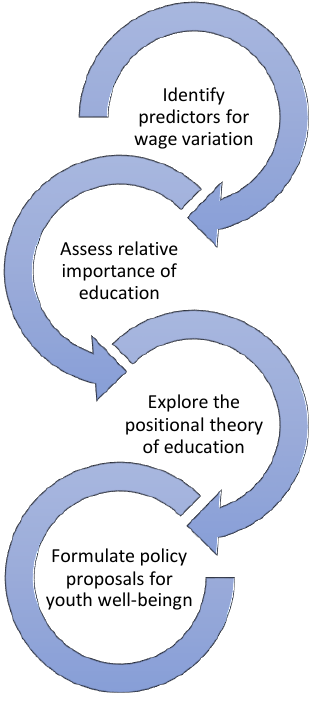
Figure 1. Key objectives of the study.